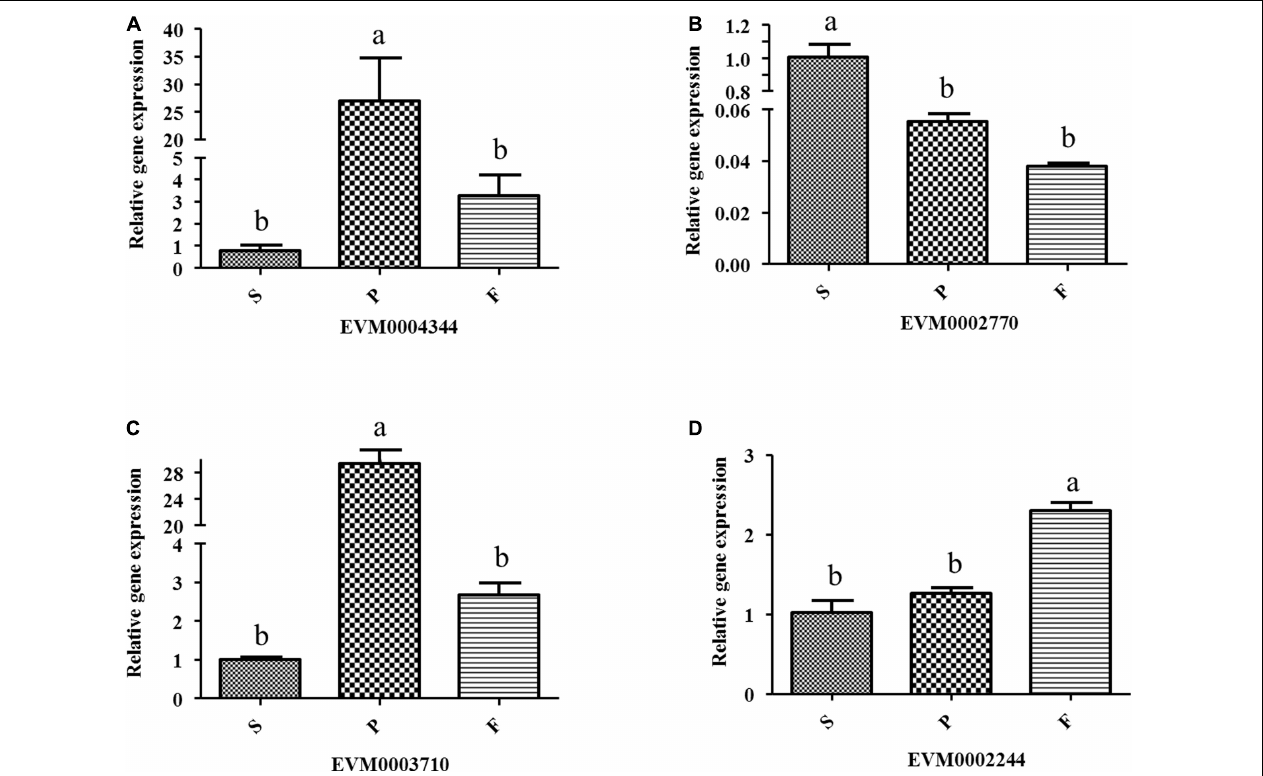
FIGURE 6 | Relative expression of some lignin oxidases and cellulases in different developmental stages of P. portentosus using RT-PCR. (A) Manganese peroxidase; (B) multicopper oxidase; (C) endo-beta-1,4-glucanase; (D) β -glucosidase. Different lowercase letters above bars indicate a significant difference according to the Duncan’s multiple range test ( p <